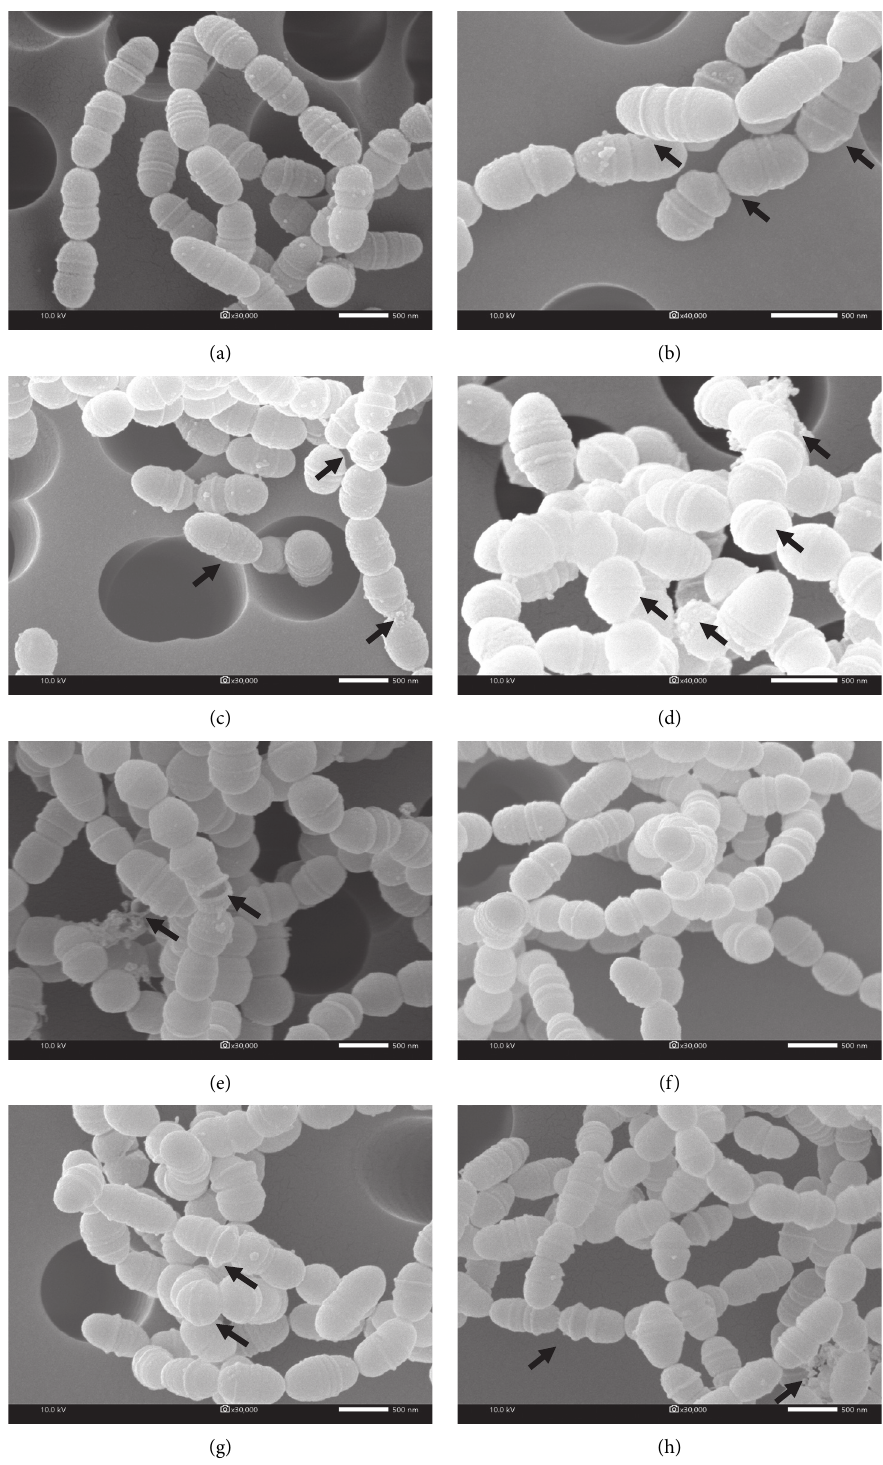
Figure 3: Scanning electron micrographs of S. mutans ATCC 25175 at 12h after treatment with control solvent (0.04% v/v Tween 80 and 0.03% v/v absolute ethanol (a), KLL oil at 4 × MIC (b), LG oil at 4 × MIC (c), GA at 4 × MIC (d), chlorhexidine at 4 × MIC (e), nisin at 1,000IU/ mL (f), GA at 0.5 × MIC (g), and the combination of nisin at 1,000IU/mL and GA at 0.5 × MIC citric acid could control the growth of S. aureus and (Figure 3(h)). The enhanced effect of GA on the anti- L. monocytogenes by inducing the release of cytoplasmic bacterial activity of nisin may be similar to the synergistic constituents including ions, DNA, and RNA [50]. effect of citric acid that the combination of nisin and